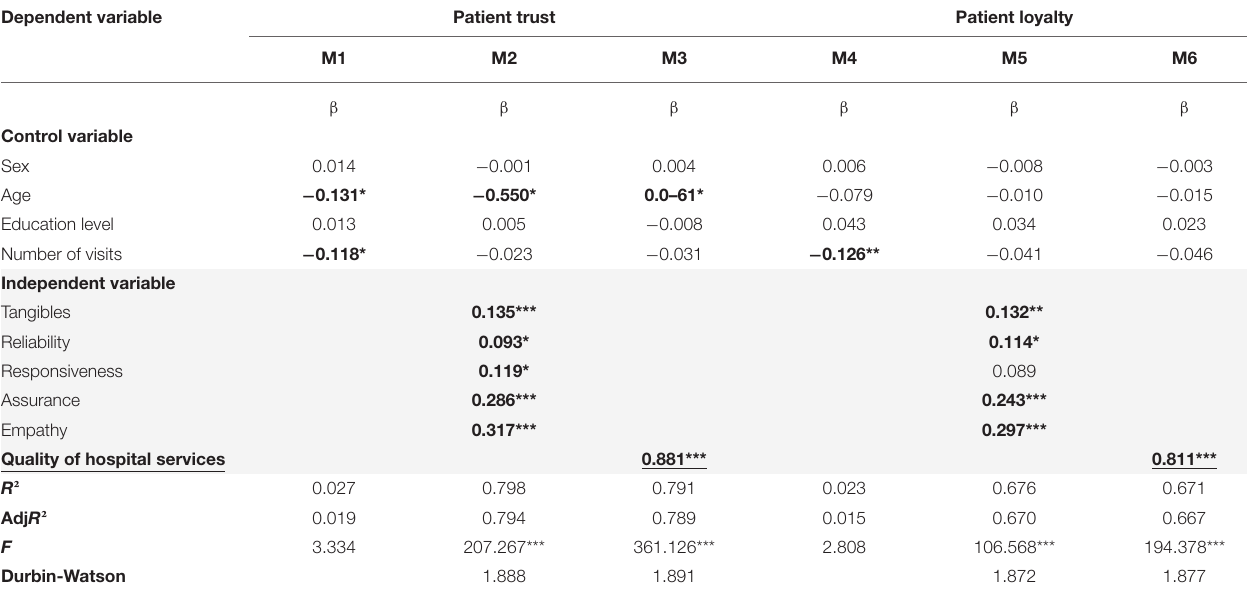
TABLE 8 | Hospital service quality and trust and customer loyalty regression analysis ( n = 483). Dependent variable